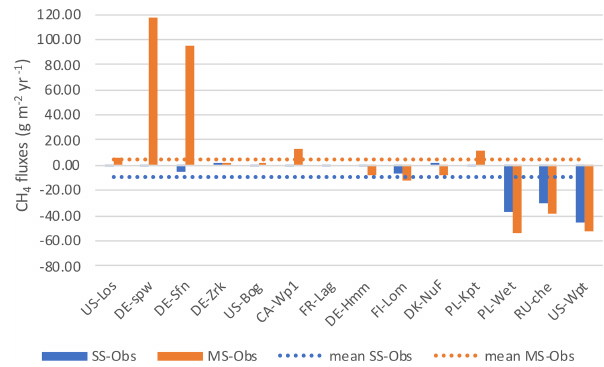
Figure 7. Difference in annual methane emissions defined between the observed data (Obs) and simulations employing optimized pa- rameters obtained by the single site optimization (SSO) and by multi-site optimization